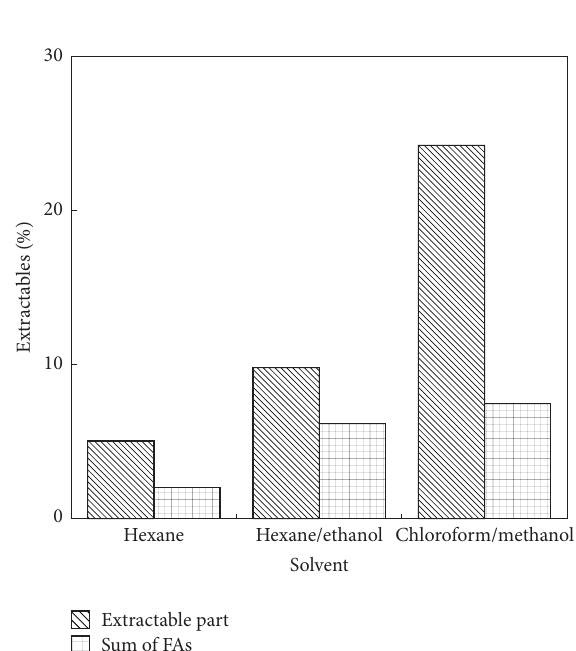
Figure 5: Cultivation growth curve with recycling water: 50 and 80%.